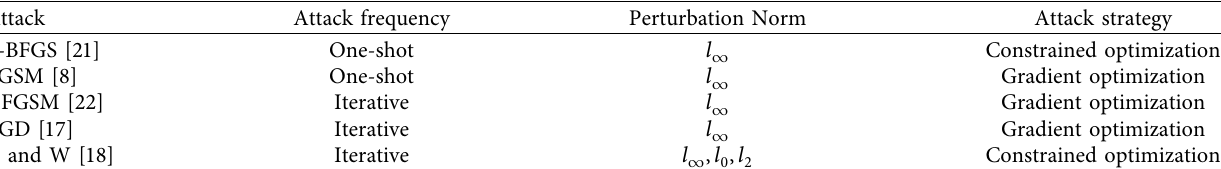
Table 1: Summary of adversarial attacks on neural